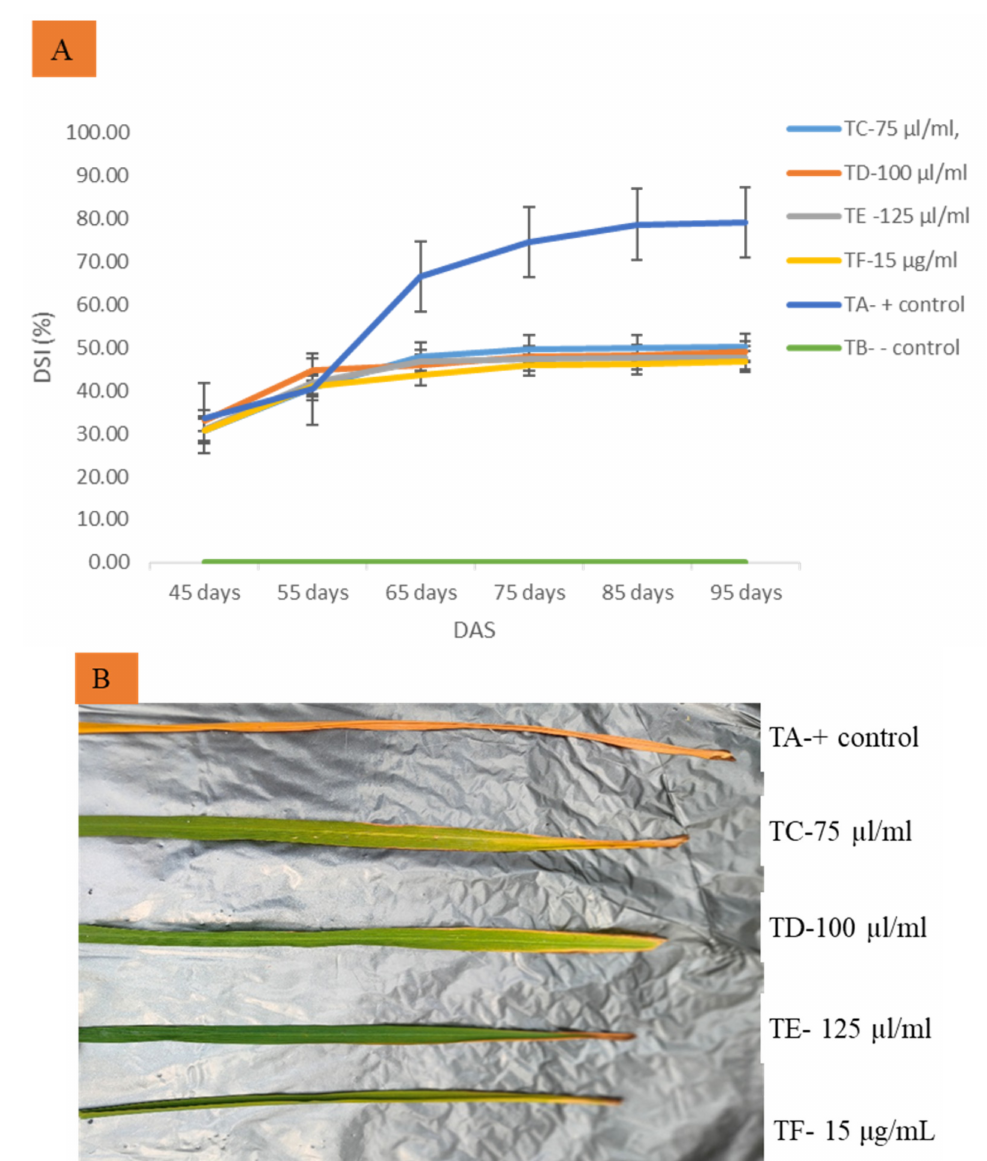
Figure 2. Effect of developed nanobactericides application on bacterial leaf blight (BLB) disease progression and severity of rice foliar symptom recorded during the glasshouse trial. ( A ) Treated rice seedlings showed low disease severity index along assessment period, ( B ) Positive control (TA) exhibited severe BLB symptoms compared with treated rice